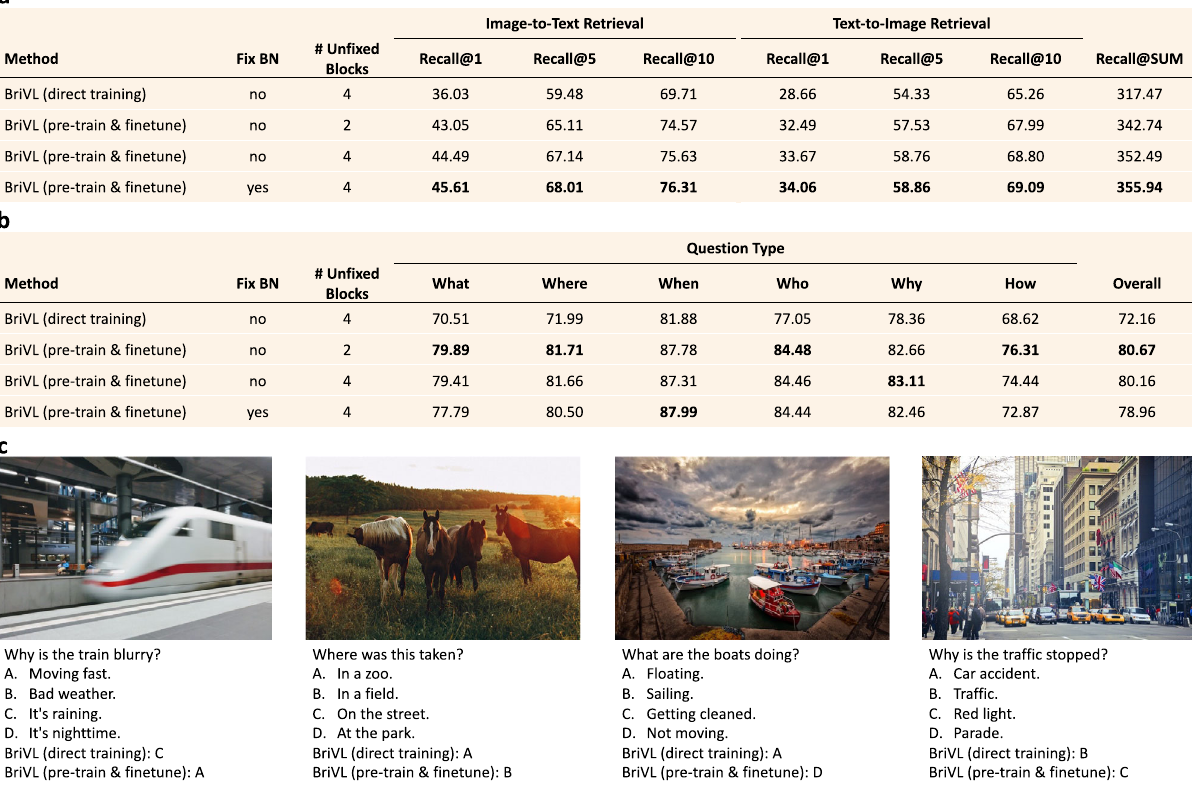
Fig. 6 Cross-modal retrieval and visual question answering (VQA) results. a Cross-modal retrieval results (%) on the Chinese dataset AIC-ICC. b VQA results on Visual7W. Overall accuracies (%) along with results on each question type are reported. The dataset is translated into Chinese. c VQA examples of our BriVL model regarding whether it is pre-trained to validate the strong imagination ability of our pre-trained BriVL. Highest results in ( a ) and ( b ) are highlighted in